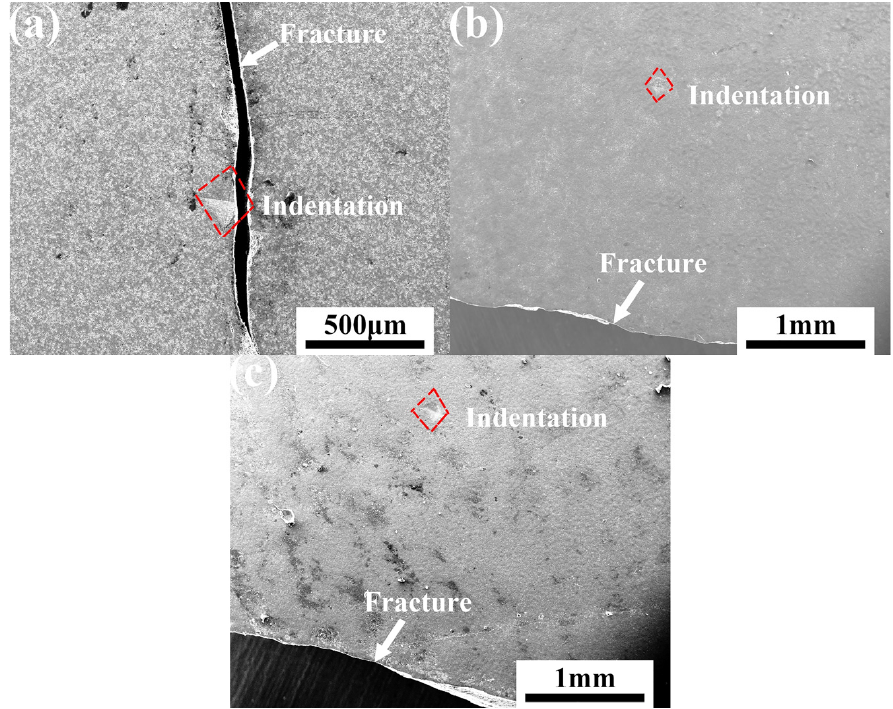
Figure 6. The flexural strength recovery of cracked specimens under different ( a ) healing temperature for 60 min, and; ( b ) healing time at 700 °C.